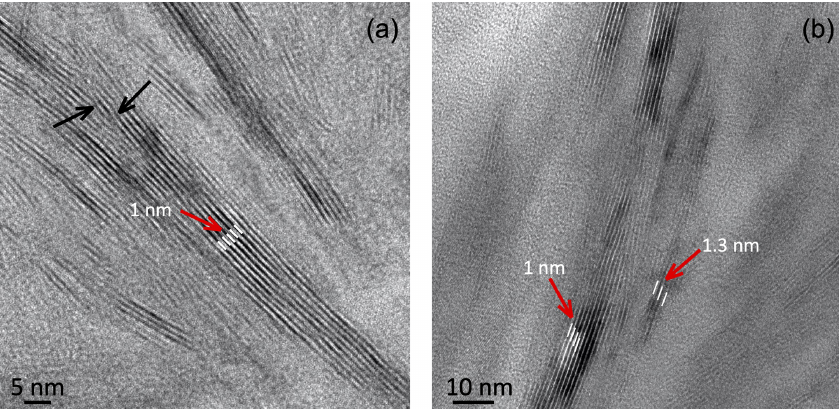
Figure 7. TEM images corresponding to glauconite: (a) aspect of the glauconite crystals with no more than 10 layers (1nm thick) and showing defects, namely, layer terminations (black arrows); (b) thin packets of glauconite (1nm layers) with smectitic layers next to them (1.3nm layers).